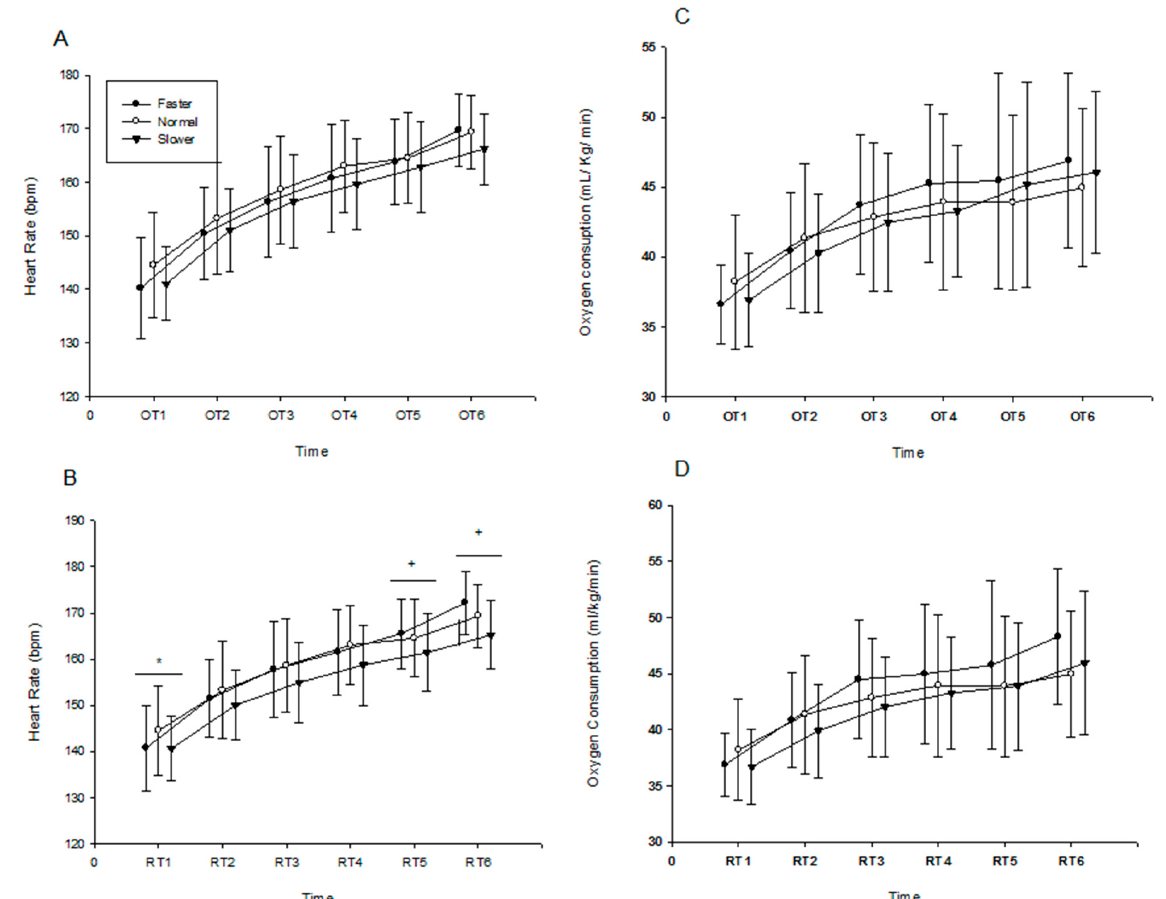
Figure 4. Physiological variables. Heart Rate (bpm) in the ( A ) observed Time (OT) and ( B ) real time (RT) analysis. Mean (± SD) data for heart rate for each condition with respect to ( A ) OT (every 10-min period of the observed time) and ( B ) RT (every 10-min period of the real time). Notes: * Significant differences between NC and both FC ( p = 0.032) and SC ( p = 0.043). + Significant differences between FC and SC, in T5 ( p = 0.043) and in T6 ( p = 0.004). Oxygen Consumption (ml/kg/min) in the ( C ) observed Time (OT) and ( D ) real time (RT) analysis. Mean (± SD) data for oxygen consumption for each condition with respect to ( C ) OT (every 10-min period of the observed time), and ( D ) RT (every 10-min period of the real time).